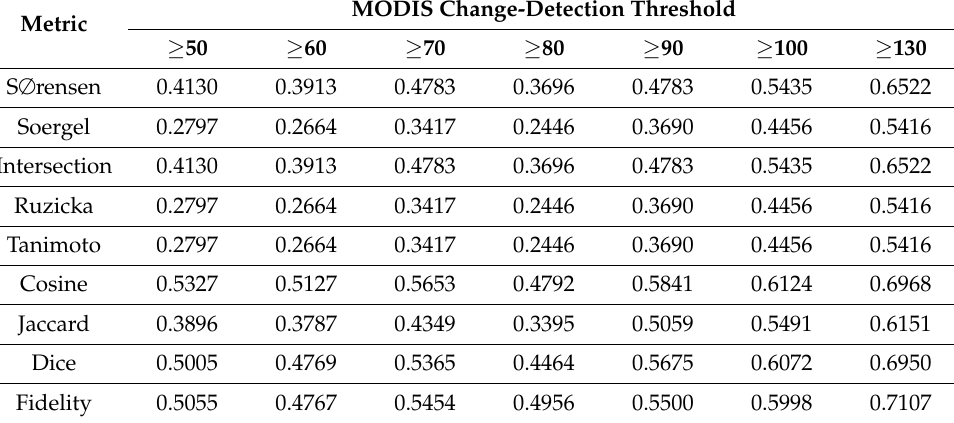
Table 4. Overall similarity (i.e., the average of similarity of θ and similarity of δ ) using nine metrics of temporal pattern between deforestation hotspots in Indonesia in 2020, derived from Landsat-8 OLI at clarity ≥ 50% and deforestation intensity ≥ 50%, and deforestation hotspots in Indonesia in 2020, derived from MODIS at change-detection thresholds ranging from 50 to 130.